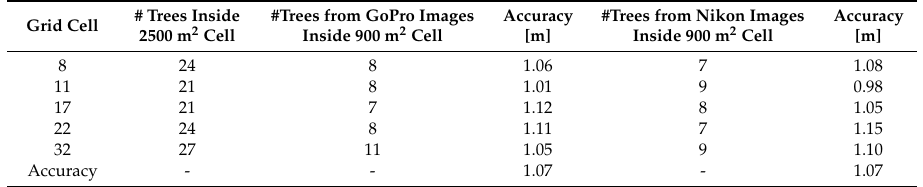
Table 1. Accuracy of tree matching for the 2500 m 2 grid cells used for geo-referencing all the trees created from trees segmented using above canopy